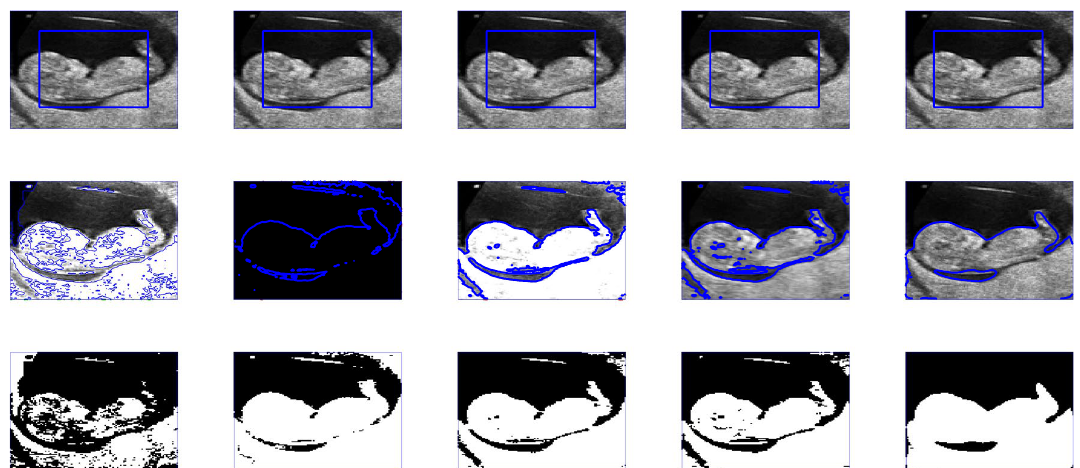
Figure 7. First, second, third and fourth columns are the segmentation results of Wu et al. 24 , Li et al. 15 , Wu et al. 12 and Krinidis et al. 31 , respectively. The fifth column is the segmentation result of proposed model with p = 0.6 , µ = 0.7, and σ = 3.